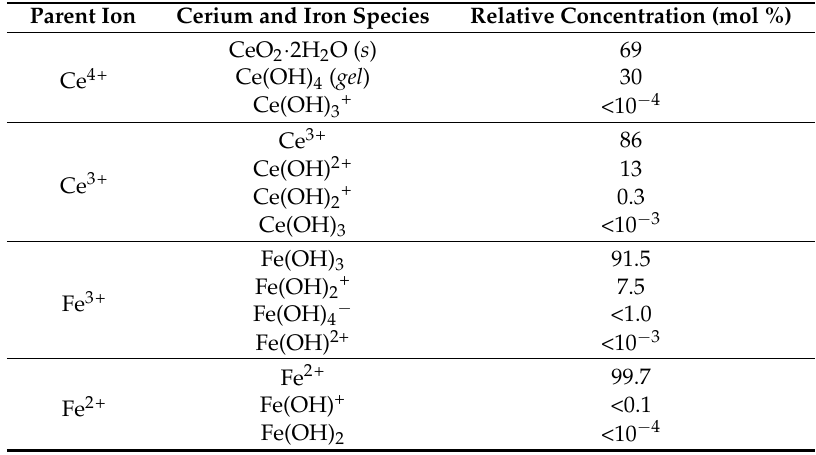
Table 2. Calculated relative concentrations of different Ce- and Fe-based species in aqueous solution at a pH of 7.60 in air. Parent